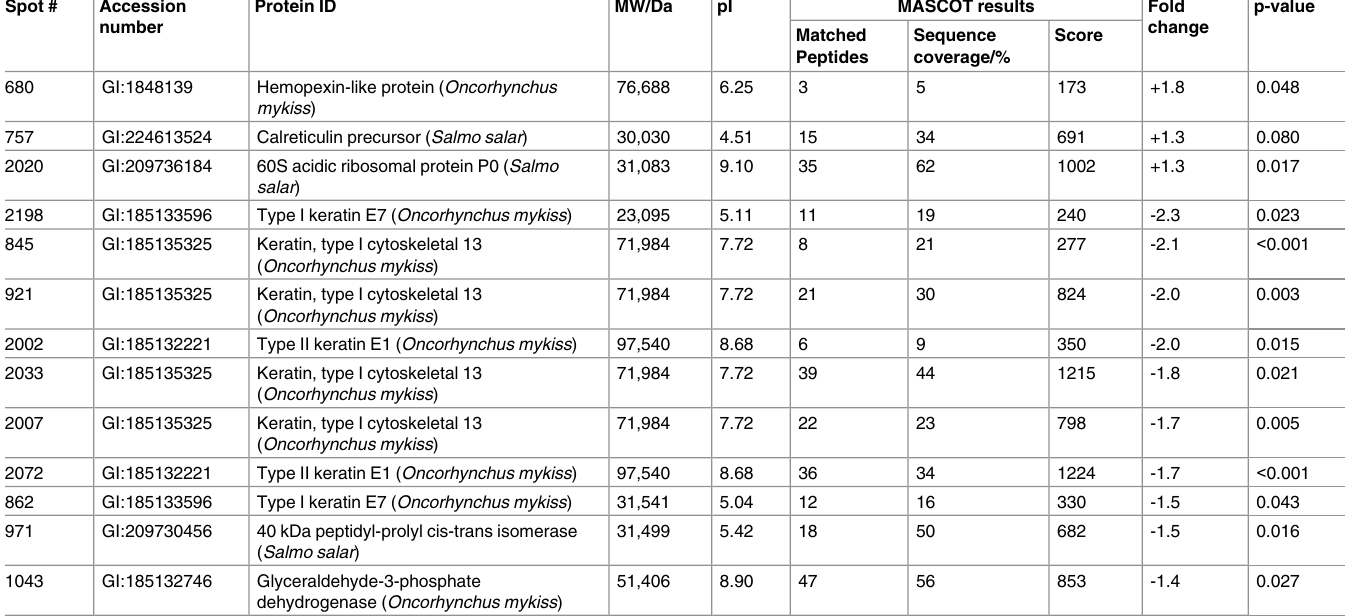
Table 3. Differentially expressedproteins in the skin of Atlantic salmon fed prebiotic dietary supplements, as identified by two-dimensional elec- trophoresis. The relevant spots were cut out from the gel and sequencedby LC-MS/MS, after which the peptideswere identifiedby a MASCOT search. The spot numbers refer to Fig 1, MW stands for molecularweight and fold changerepresents the expressionlevel in the experimental fish group as comparedto the control.